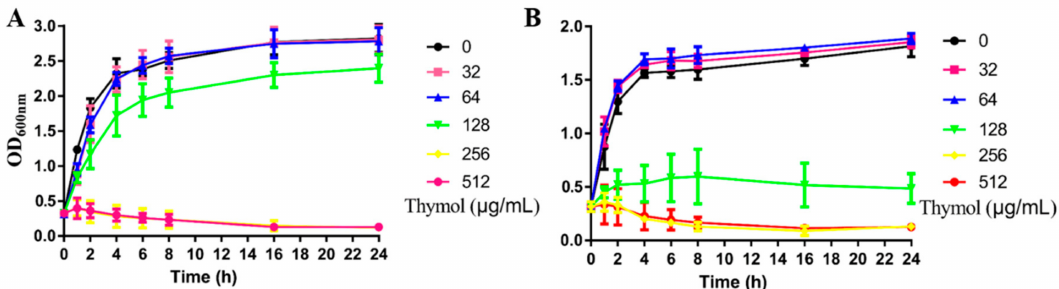
Figure 1. Growth curves of TCH1516 in brain heart infusion (BHI) containing di ff erent concentrations of thymol. ( A ) Under shaking conditions. ( B ) Under static conditions.